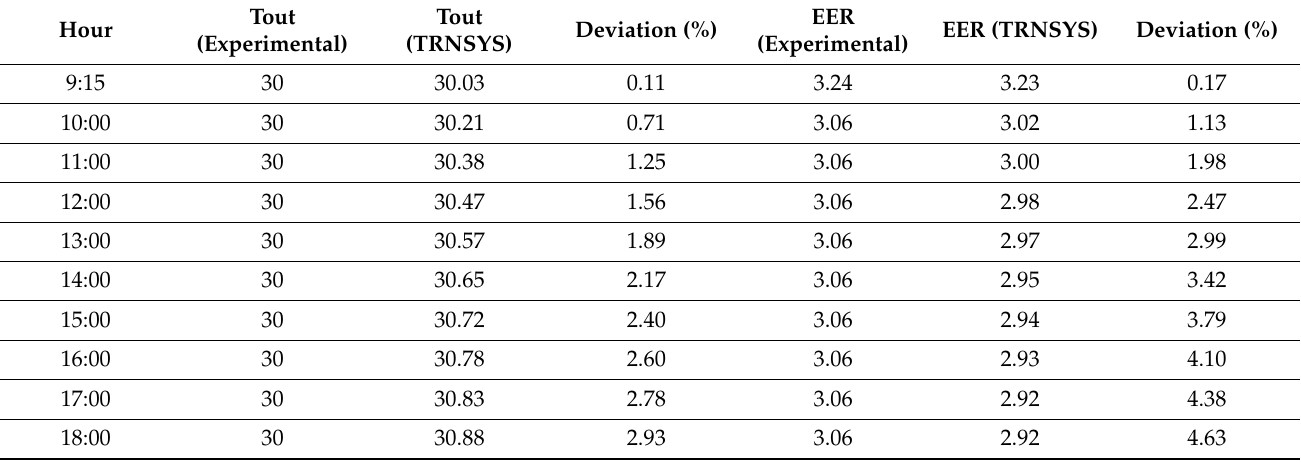
Table 3. Results and deviation of the performance of the simulation and experimental data at 1 GPM.